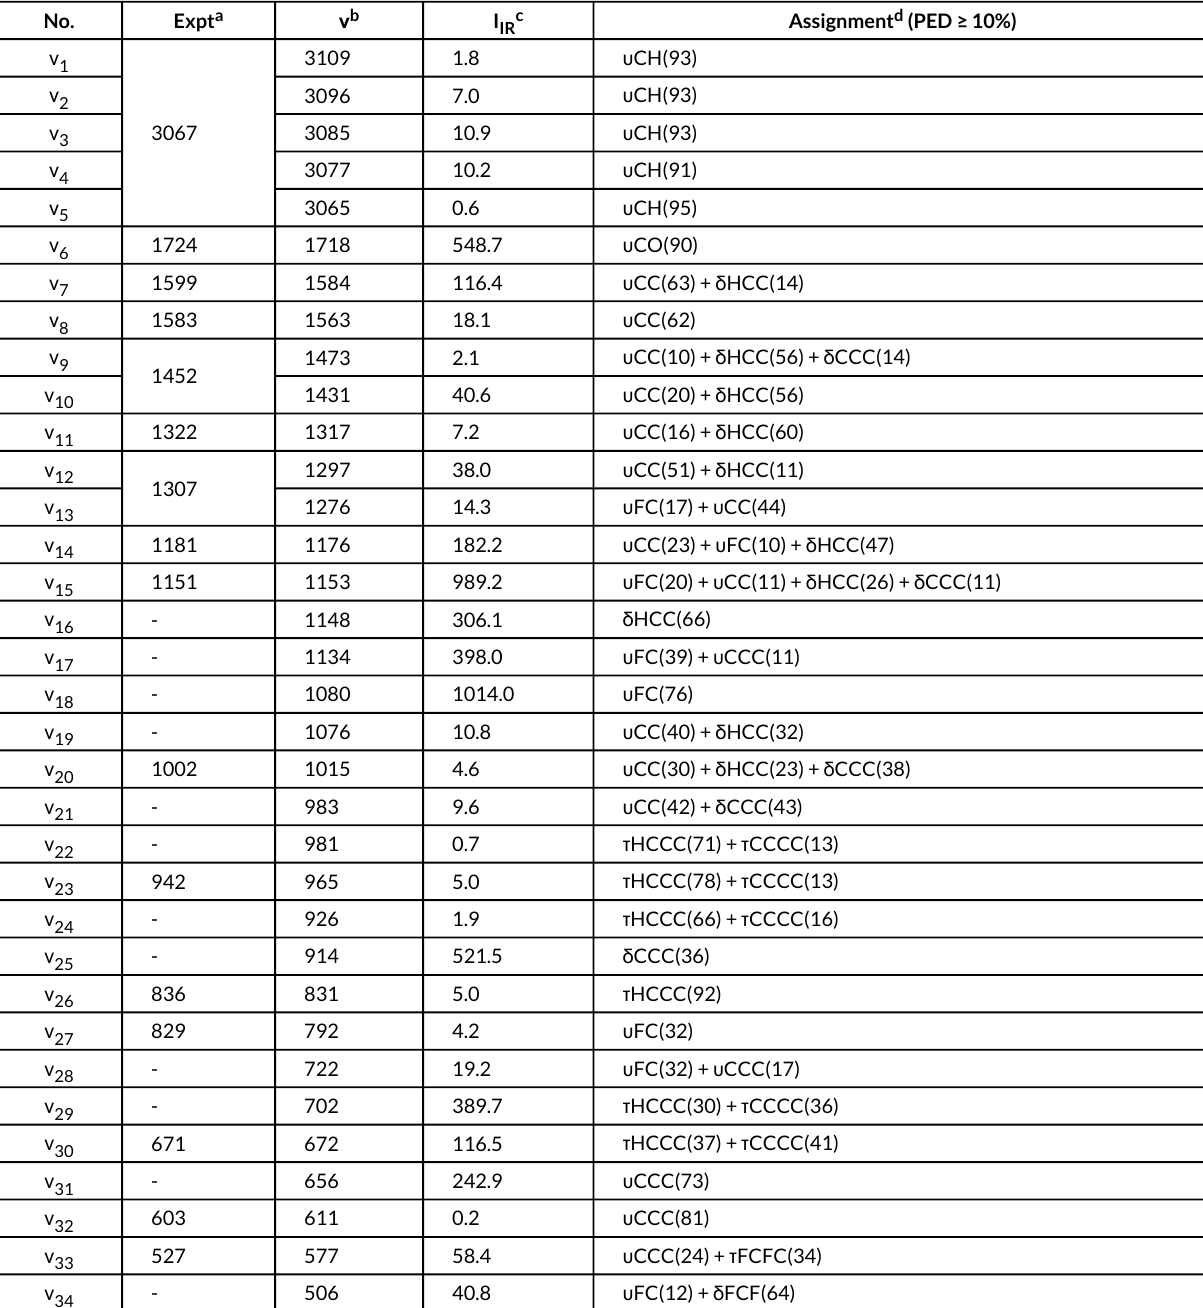
Table 2. Experimental and calculated vibrational wavenumbers (cm -1 ) of